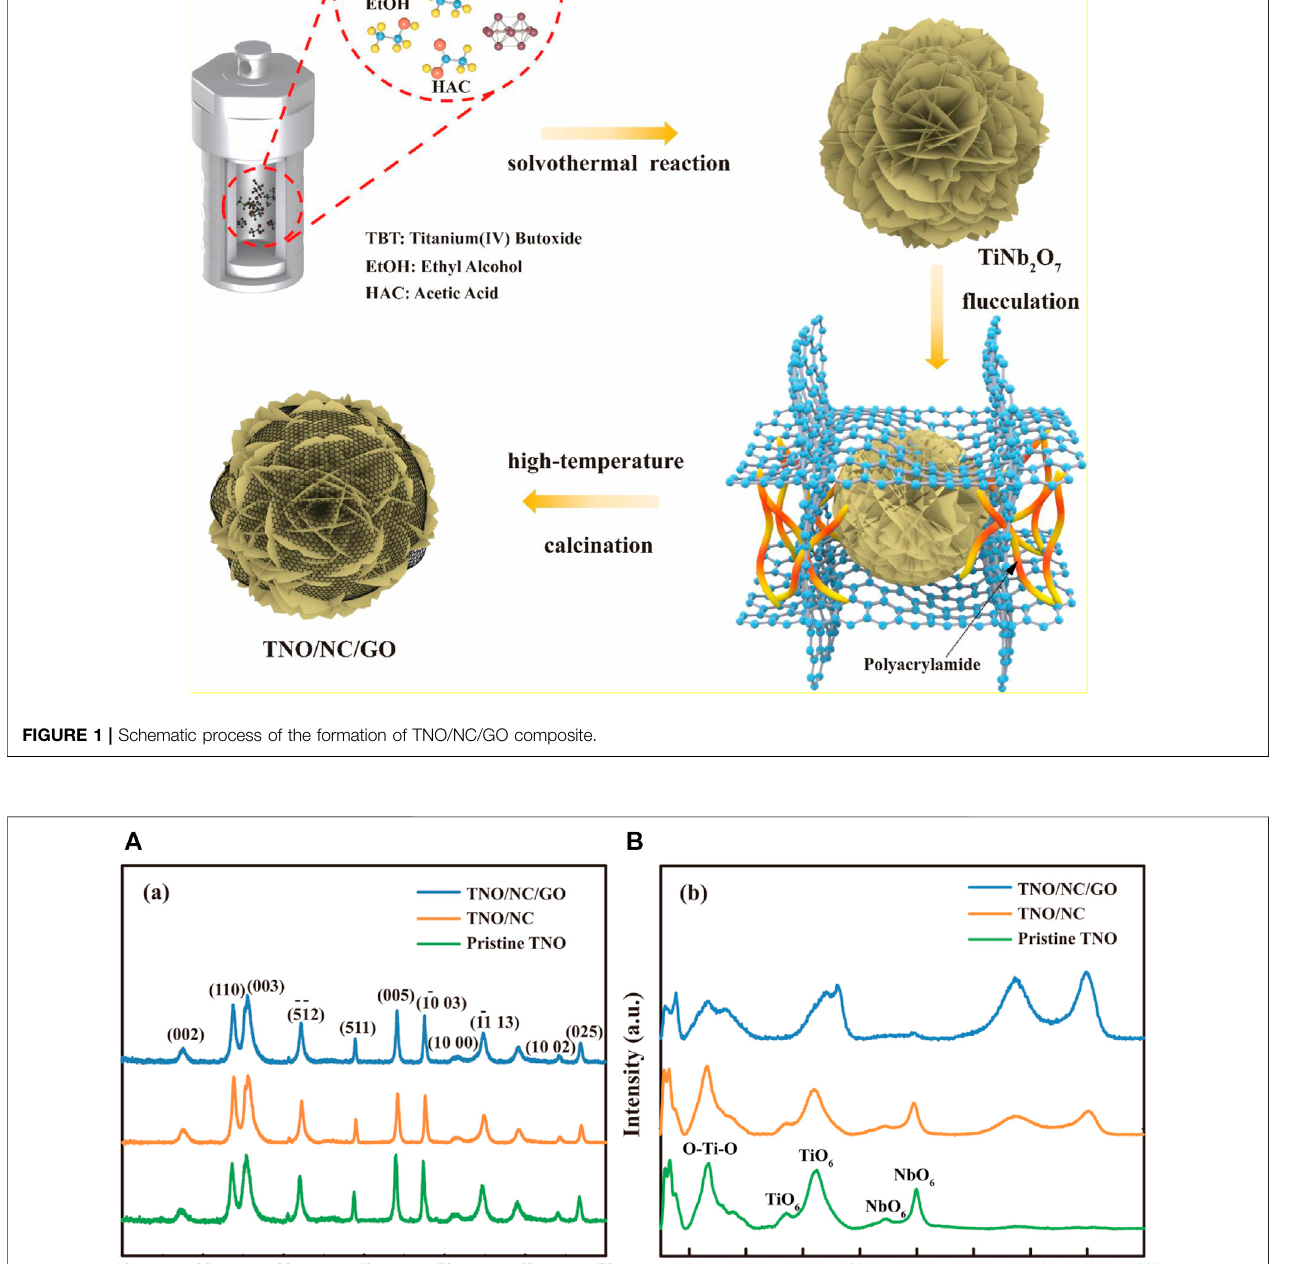
Frontiers in Energy Research |